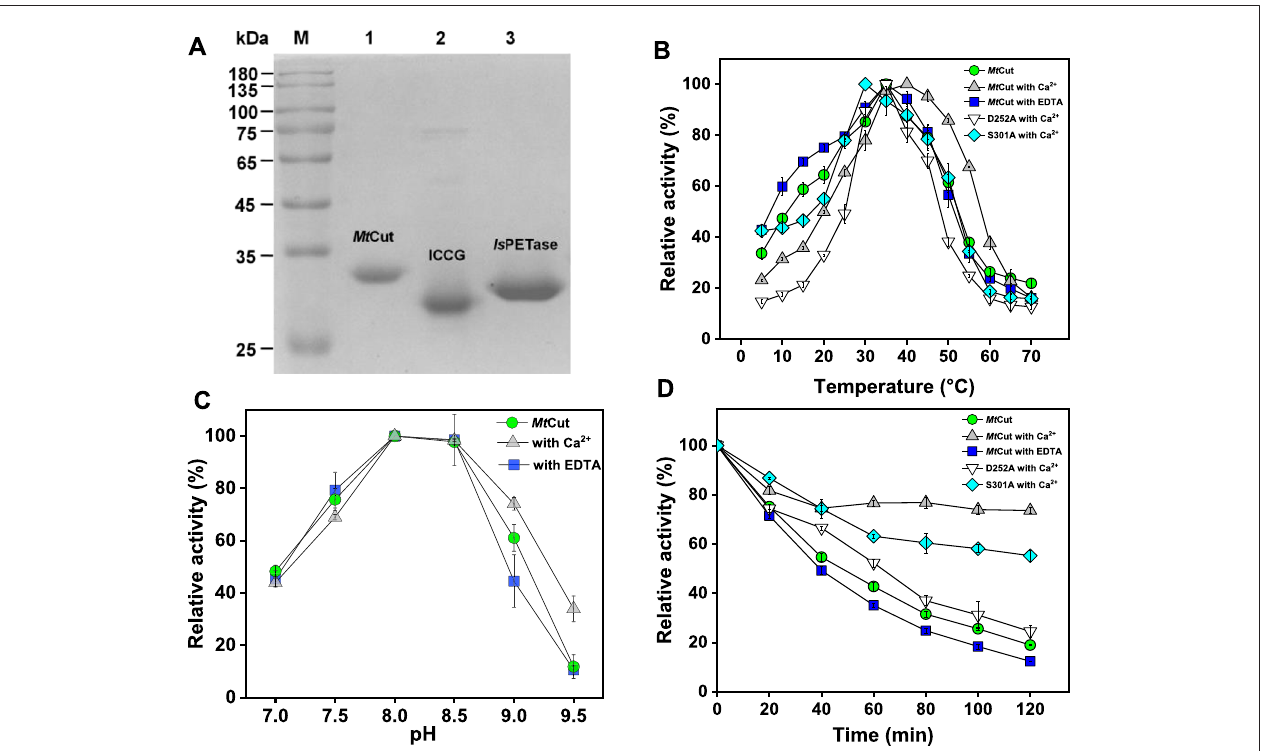
FIGURE1| Cutinaseactivityof Mt Cut. (A) Mt Cut,ICCG,and Is PETaseproteinpurity.Theimpactoftemperature (B) andpH (C) oncutinaseactivityof Mt Cutandits mutants. (D) Thermal inactivation pro fi les of Mt Cut and its mutants in the absence/presence of 1 mM calcium ions or EDTA at 30 ° C. All the tests used p NP butyrate as